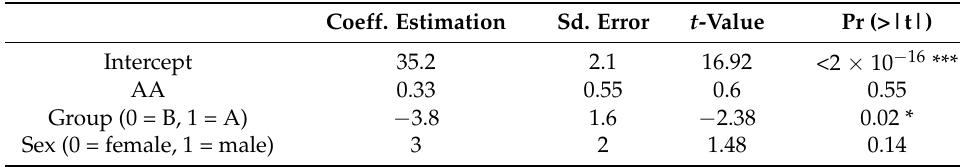
Table 3. Multiple regression models parameters.